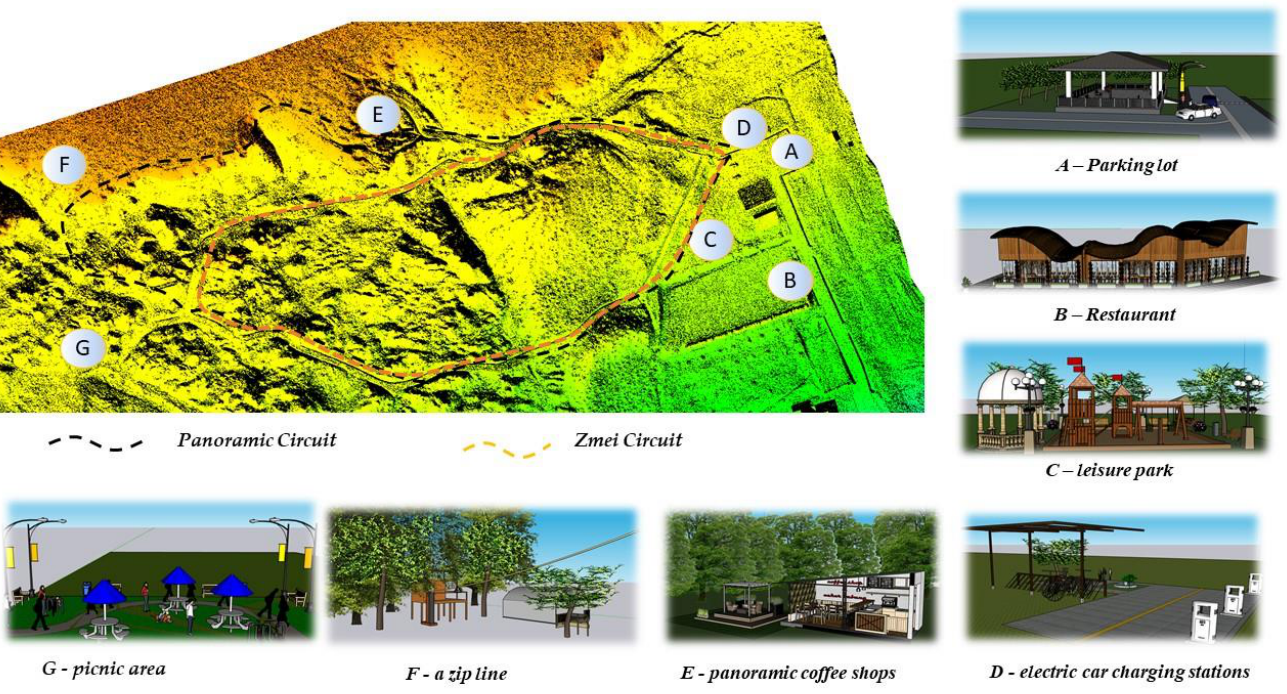
Figure 6. The proposed tourist infrastructure for the Grădina Zmeilor geomor phosite.